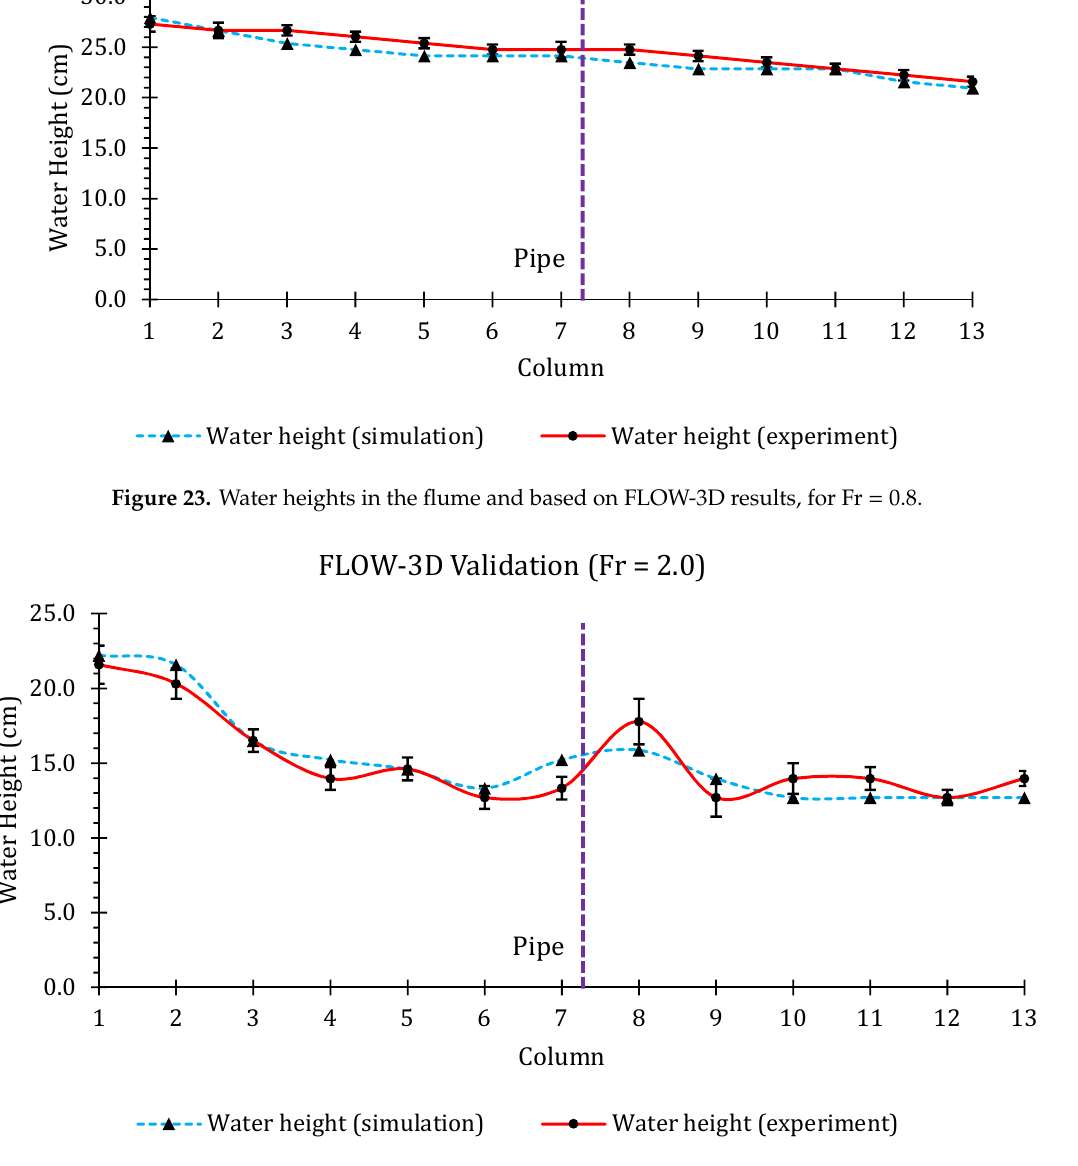
Figure 24. Water heights in the flume and based on FLOW-3D results, for Fr = 2.0.